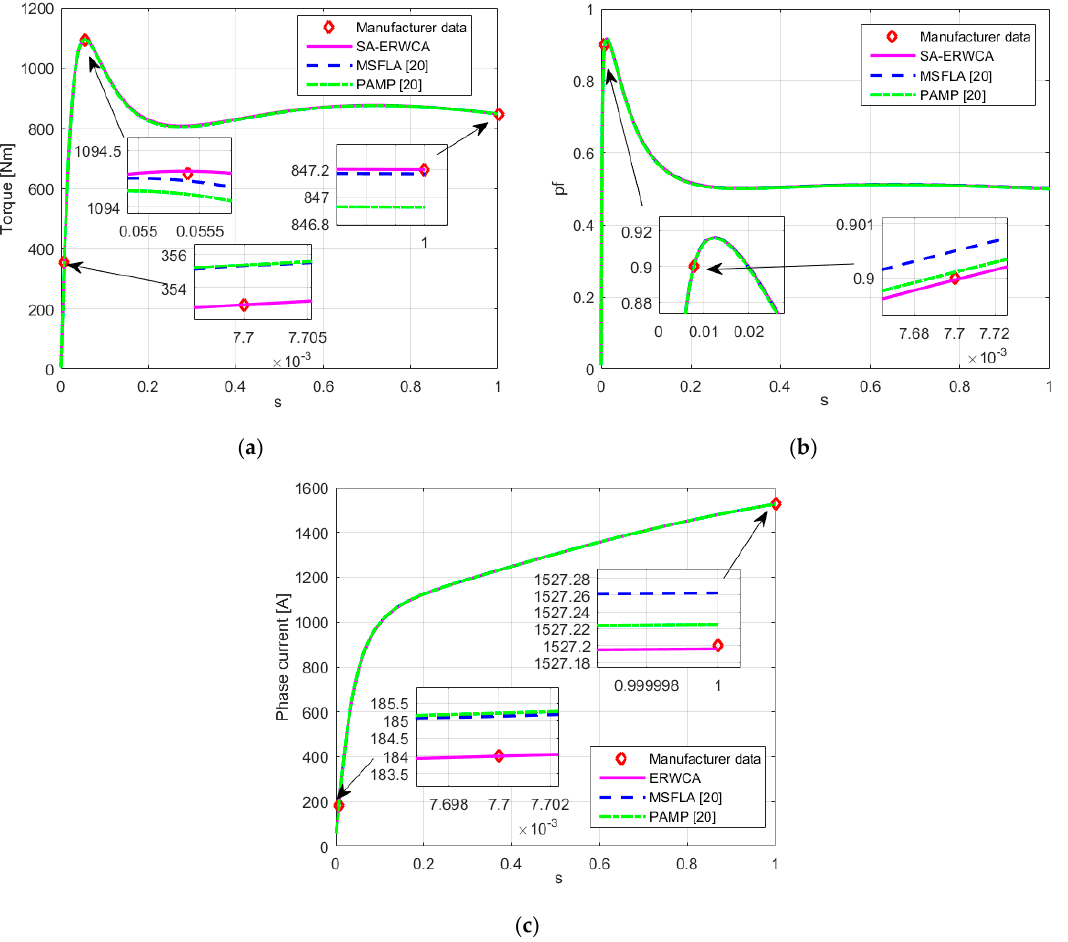
Figure 6. Curves of Machine 2: ( a ) Torque versus slip; ( b ) power factor versus slip; and ( c ) phase current versus slip.